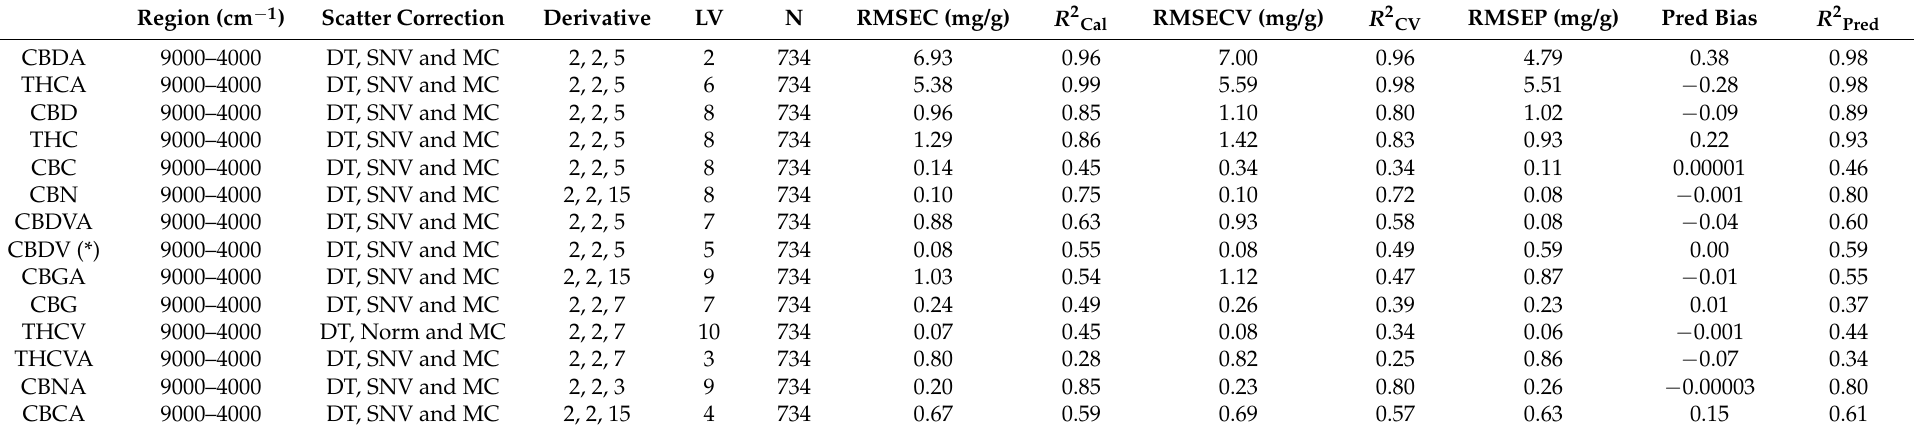
Table 3. The different pre-processing methods applied to partial least squares regression models (PLS-R) for the determination of cannabinoid compounds using data from the Bruker MPA instrument.